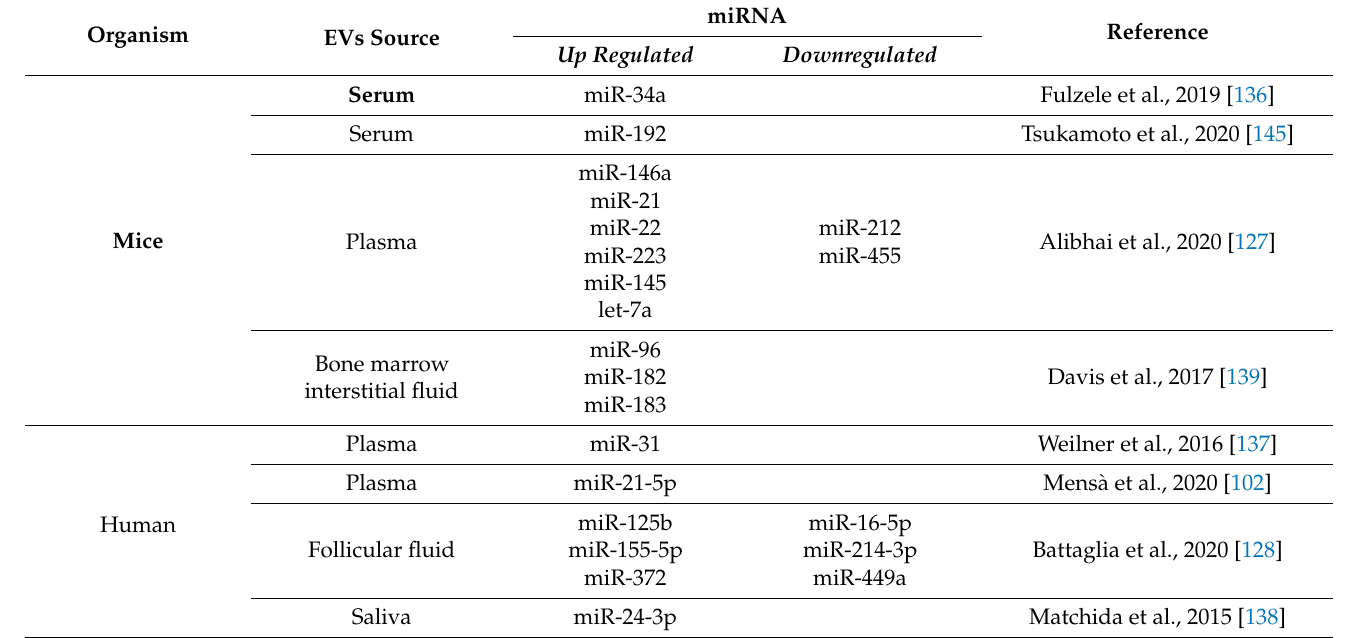
Table 1. The table shows the main studies comparing miRNAs present in the EVs from biofluids of young and old subjects, listing the main species differentially expressed in aged vs. young subjects, potentially useful as aging